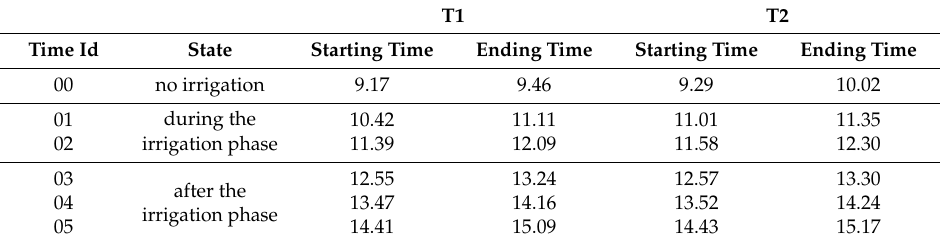
Table 1. Three-dimensional (3-D) electrical resistivity tomography (ERT) data collection time (local